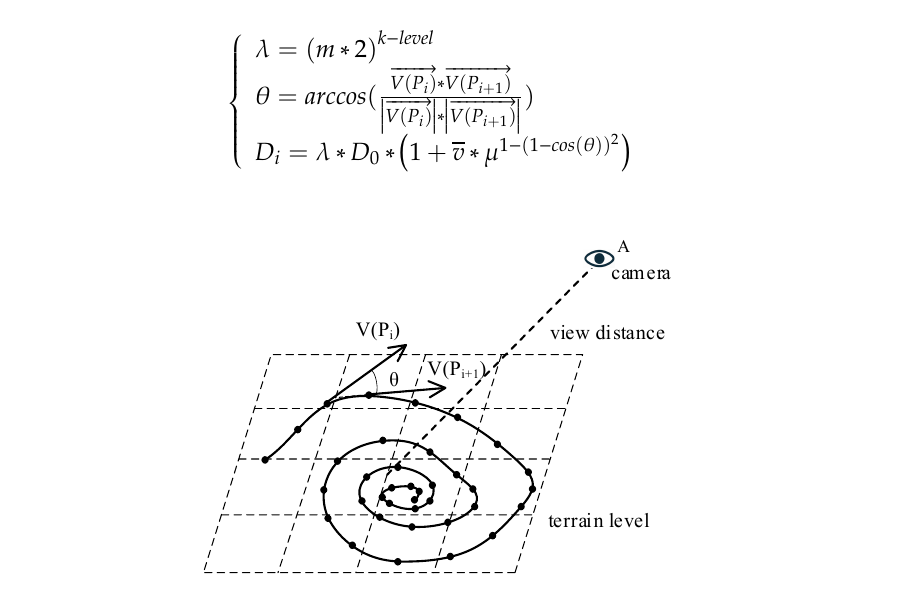
Figure 10. Equivalent point calculation: ( a ) the contour line passes through the two vertices; ( b ) the contour line crosses one of the vertices.